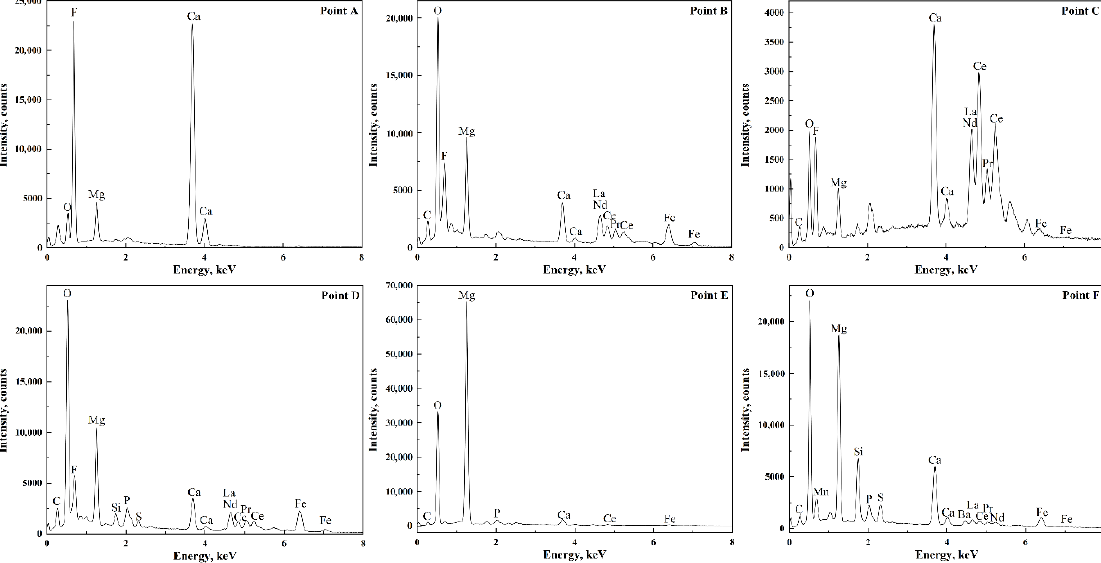
Figure 8. Effect of roasting temperature and holding time on the decomposition rate of RE minerals. With the hold time of 120 min, the maximum decomposition rates at 600 °C, 650 °C, 700 °C, and 750 °C reached 76.45%, 81.97%, 92.44%, and 98.09%, respectively. It should be noted that the decomposition rates for all the cases exceeded 60% during the temperature- rising stage. The SEM-EDS results of the leaching residues are shown in Figures 9 and 10